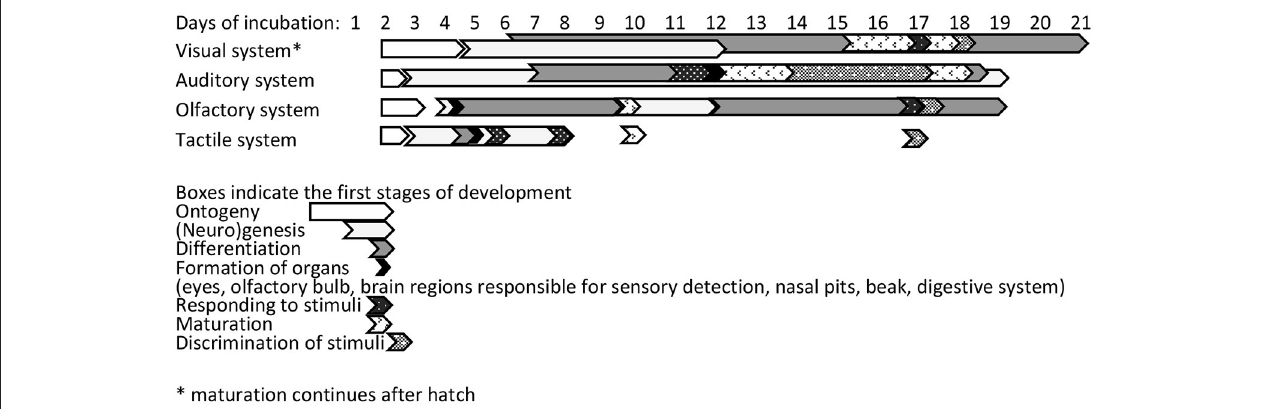
FIGURE 4 | Timeline for sensory development of chicken embryos during incubation [based on (78)].